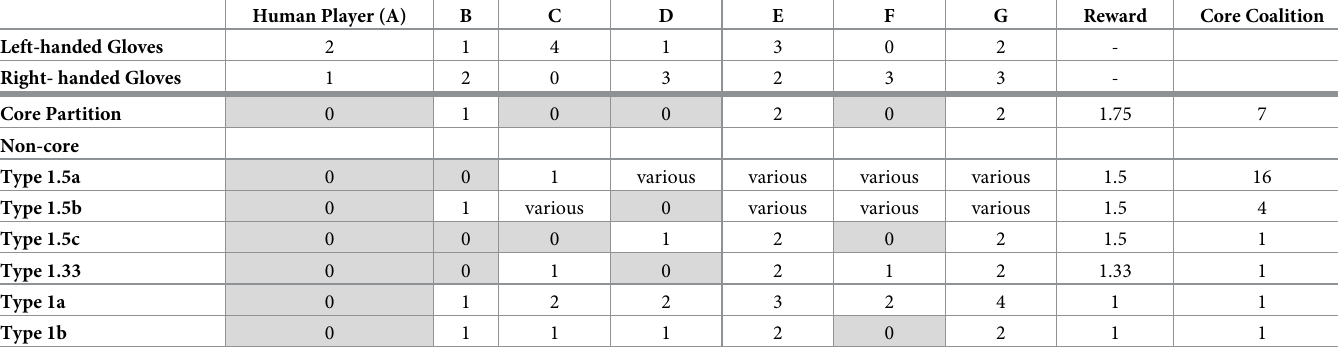
Table 5. Final coalition structures for the game with a single